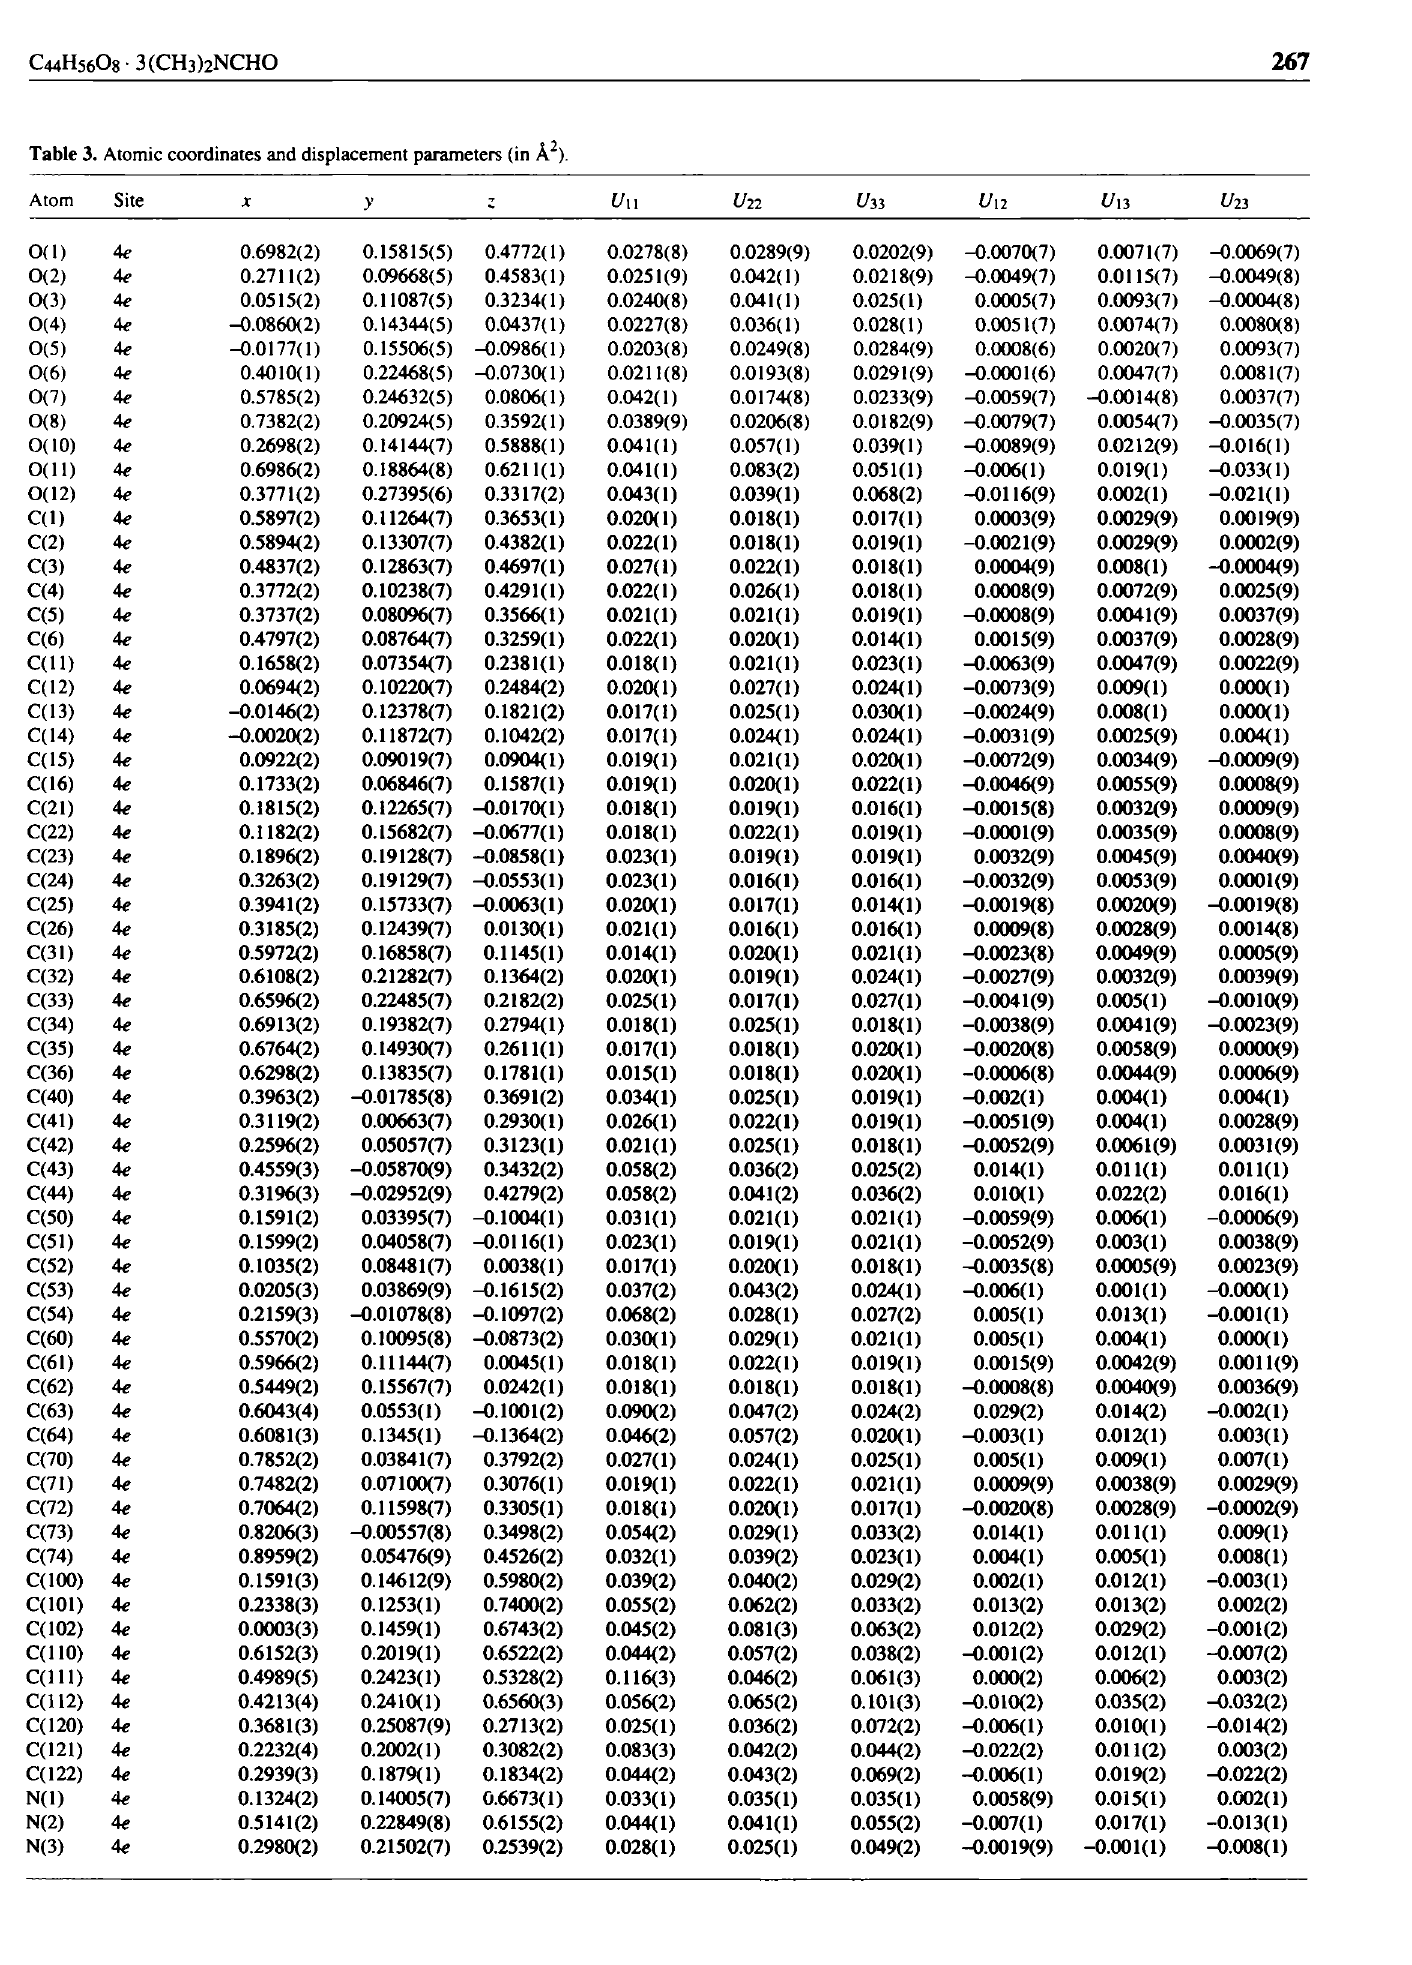
Table 3. Atomic coordinates and displacement parameters (in A 2